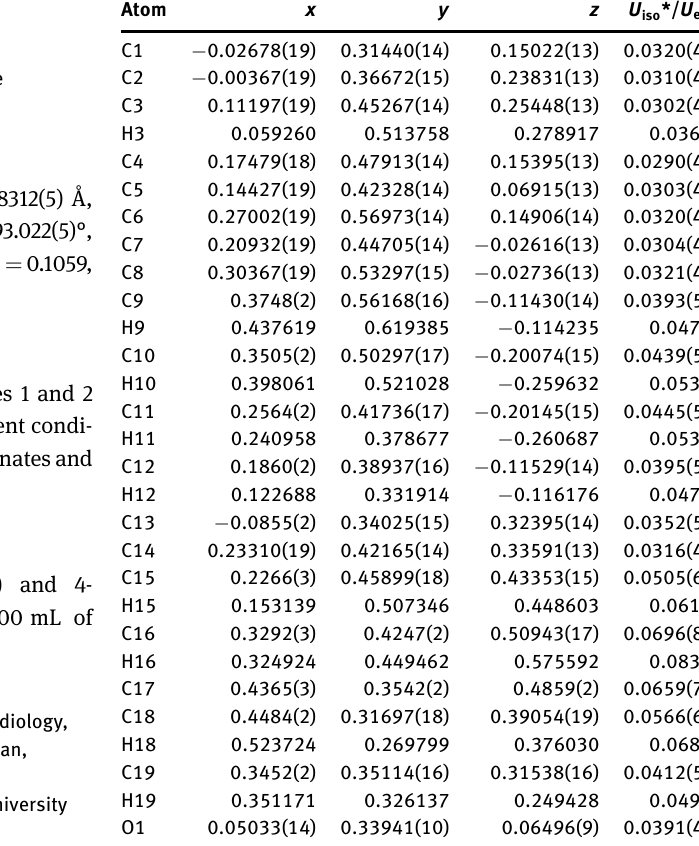
Table 2: Fractional atomic coordinates and isotropic or